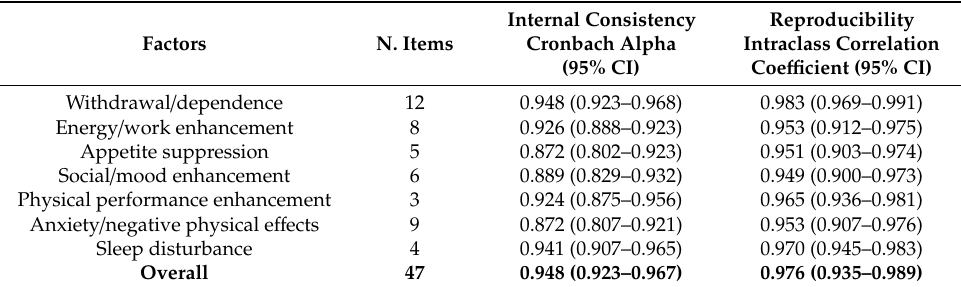
Table 1. Reproducibility and internal consistency of the instrument and factors of the Ca ff eine Expectancy Questionnaire in Brazil (Ca ff EQ-BR)